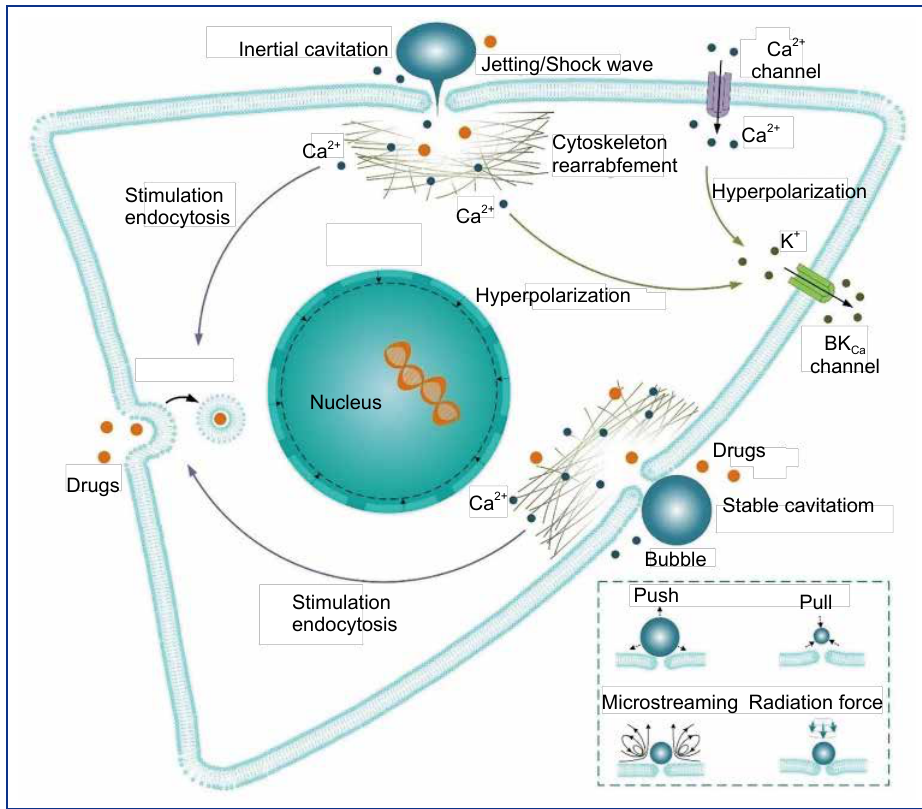
Figure 4 Schematic overview of major biophysical effects occurring during sonoporation generated by stable and inertial cavitation microbubbles. (Reprinted with permission from reference